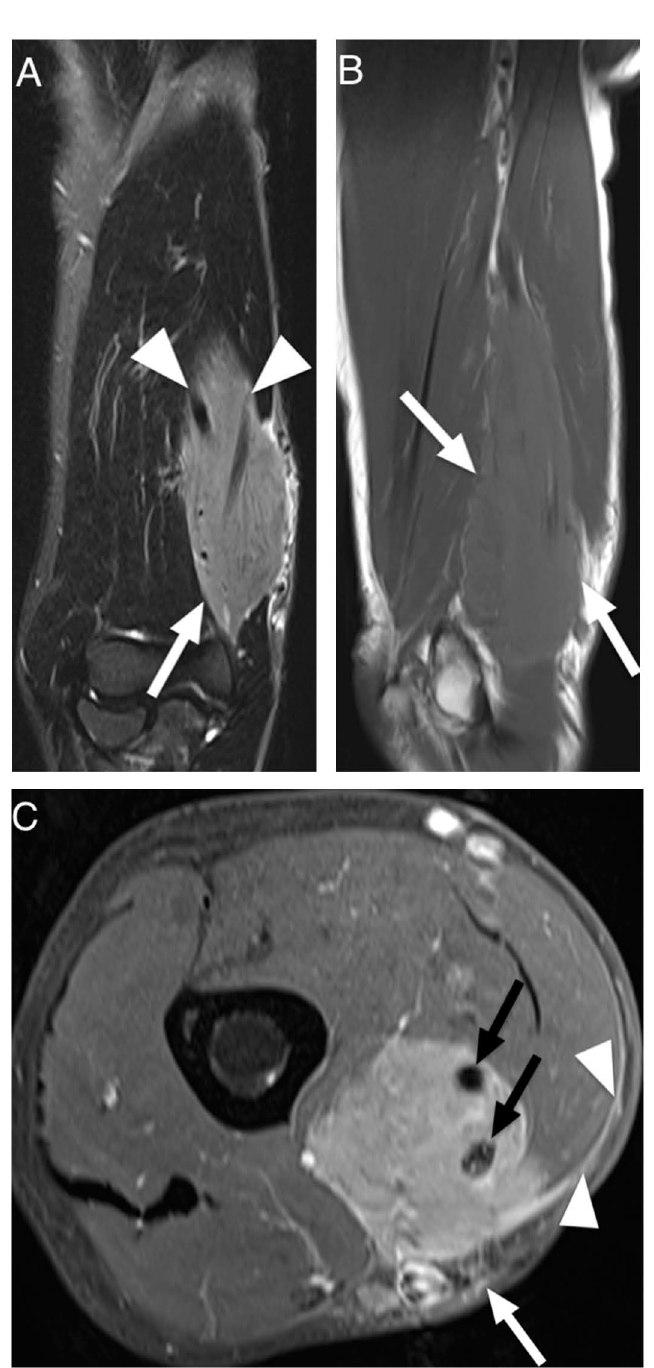
Figure 2. MRI of a 73-year-old man presenting with non-Hodgkin lymphoma manifestation in the flexor compartment of the upper arm. ( A ). Coronal T2-weighted TIRM image shows tumor of hyperintense signal intensity compared to muscle (arrow) and growth along the brachial neurovas- cular bundle (arrowheads). ( B ). Sagittal T1-weighted image shows long segmental involvement (arrows) and slightly hyperintense signal intensity of tumor in comparison to adjacent skeletal muscle. ( C ). Transversal contrast enhanced fat-saturated T1-weighted image shows homogenous contrast-enhancement of the lymphoma with encasement of the brachial neurovascular bundle (black arrows). Furthermore, subcutaneous stranding (white arrow) and contrast enhancement of the deep peripheral fascia (arrowheads) can be seen.